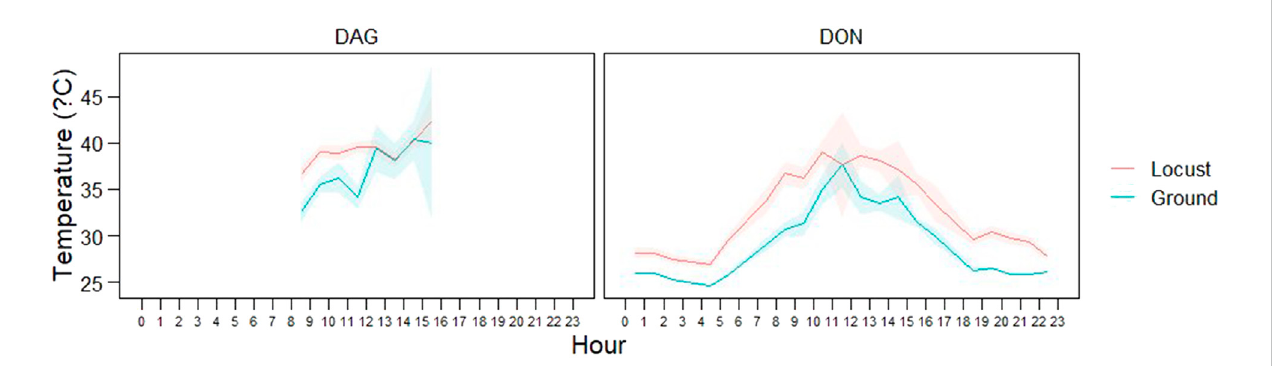
FIGURE 5 Diurnal patternoflocustbody temperature(red) andgroundtemperature (blue)inthetwostudy areas: Dagang(left)and Dongying (right). Foreachhour the plot indicates the mean (line) and con fi dence intervals (i.e., standard